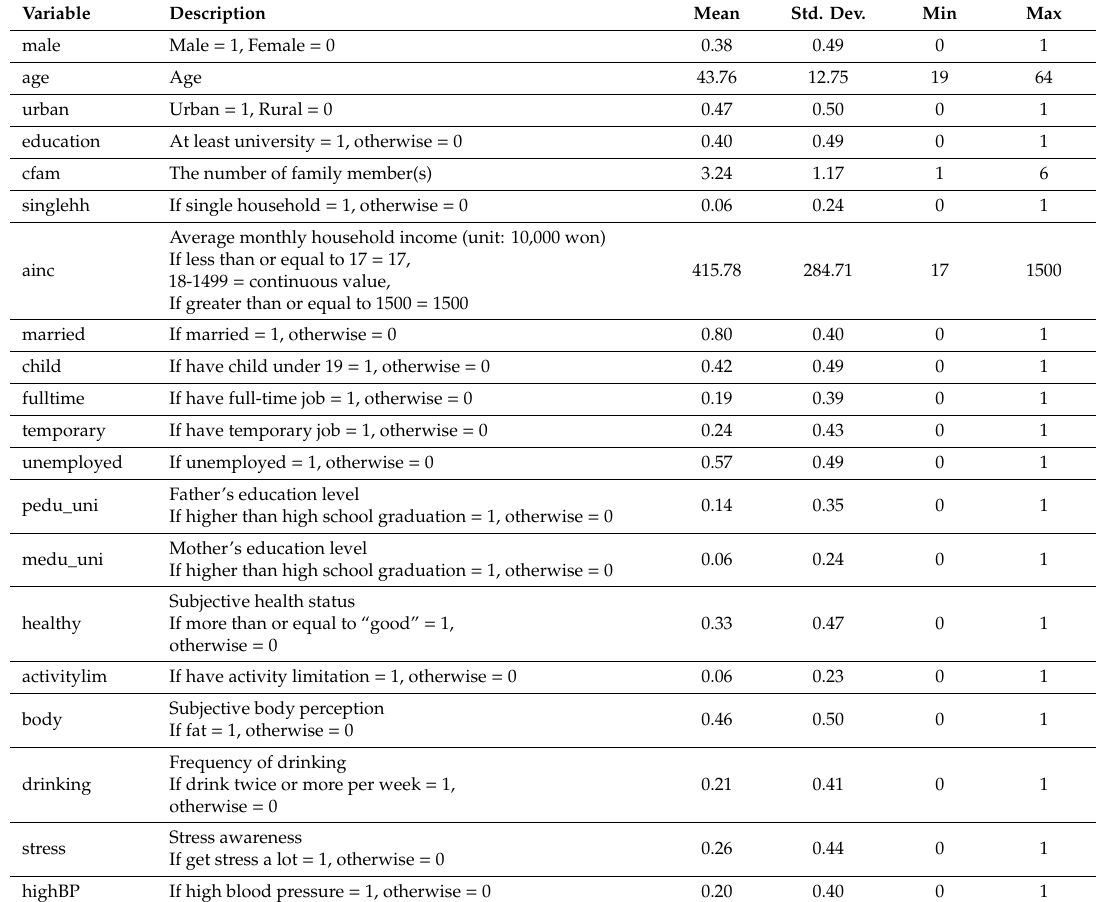
Table 3. Descriptive statistics of